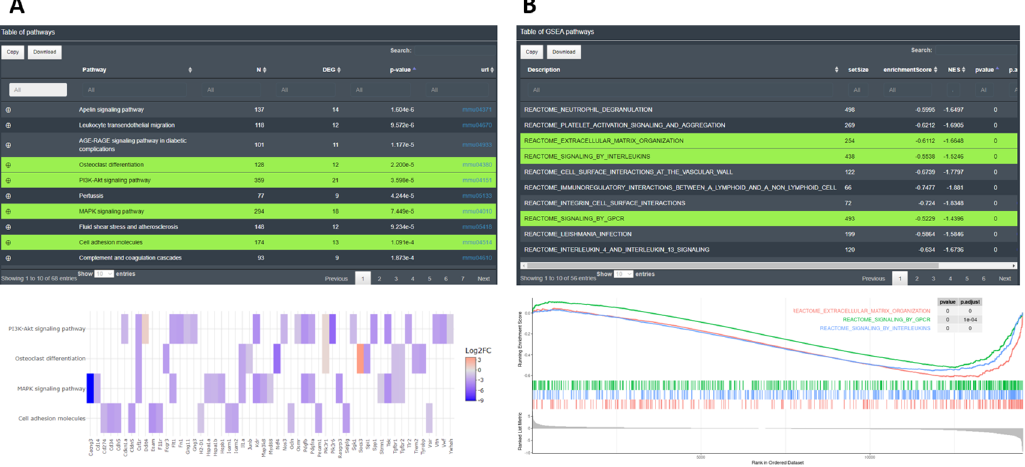
Figure 9. Examples of enrichment analysis with DEVEA. A: KEGG EA table and heatmap. B: GSEA table and